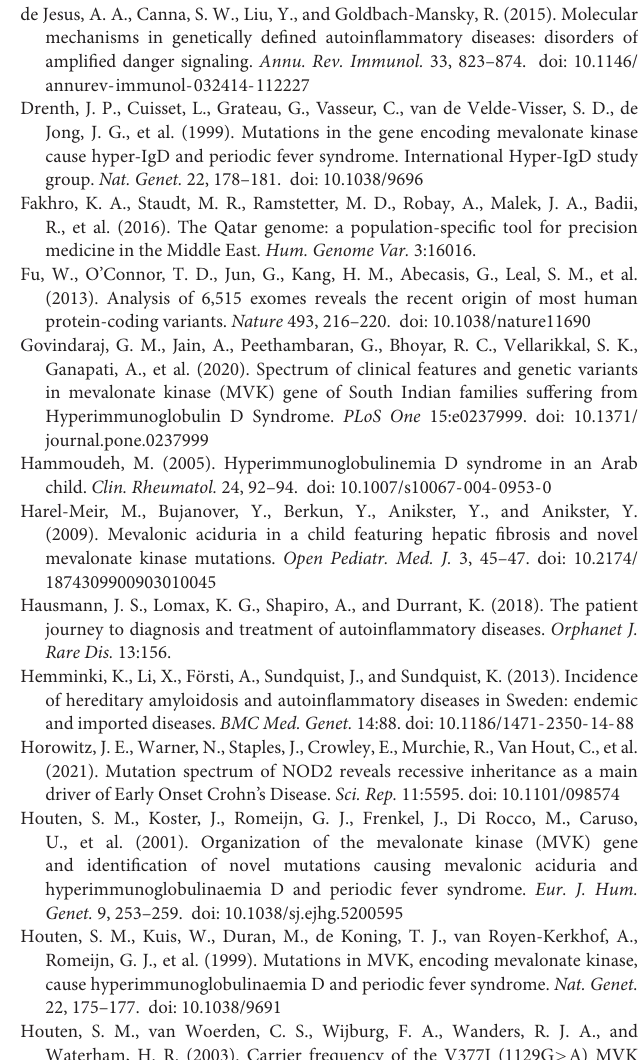
Supplementary Data Sheet 1 | The ACMG-AMP guidelines for each